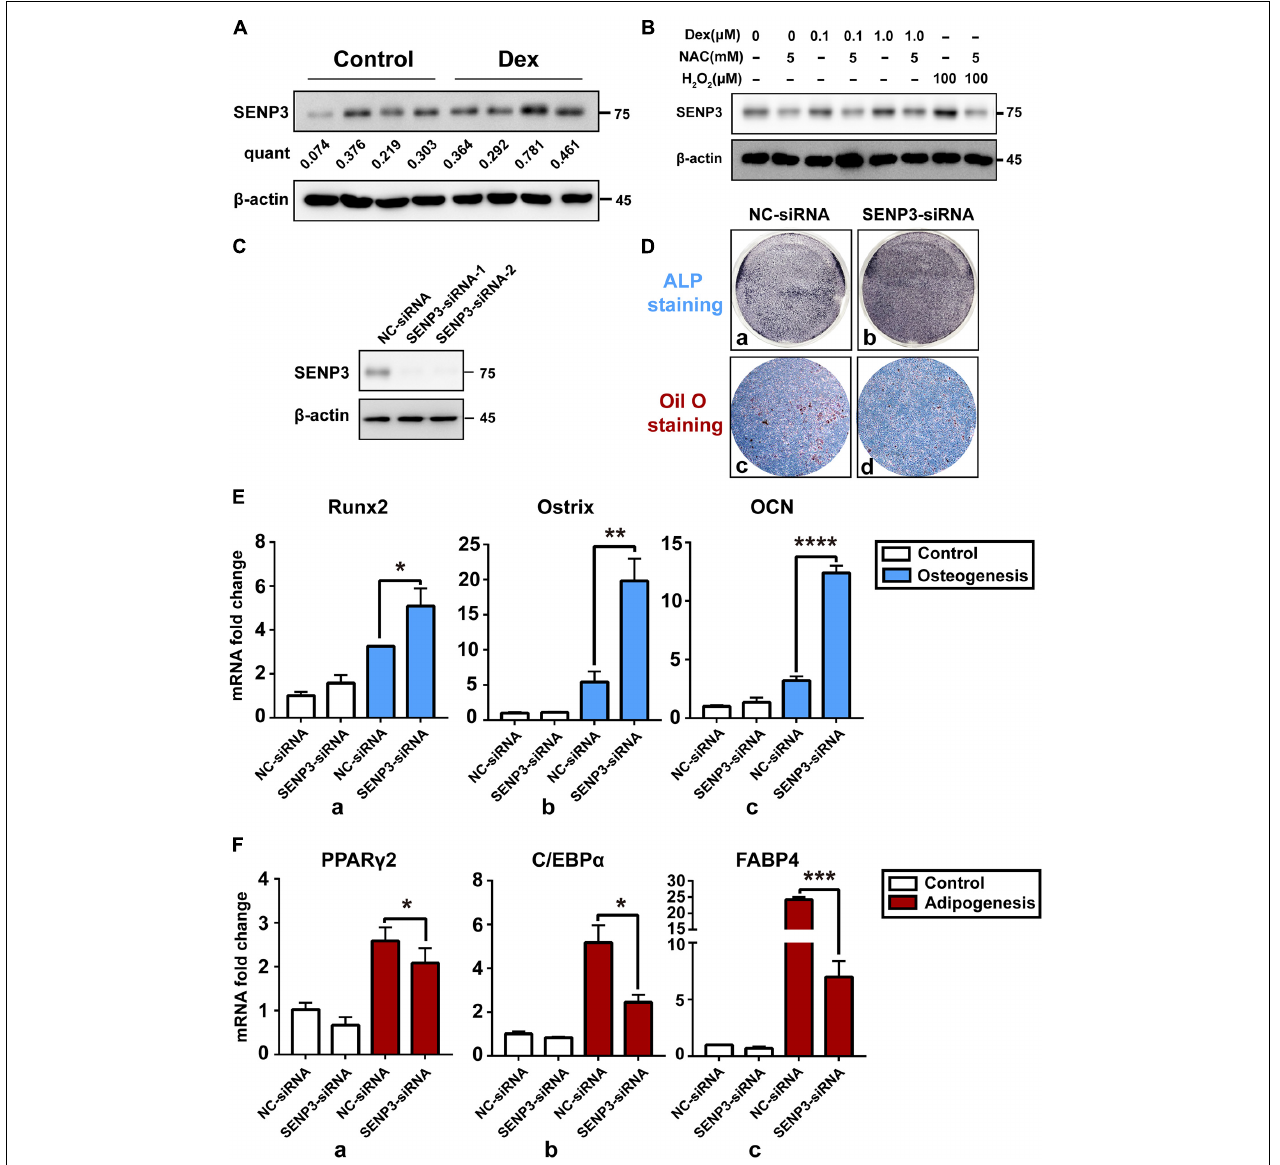
FIGURE 3 | Upregulated cellular SENP3 under oxidative stress in BM-MSCs can promote adipogenesis and inhibited osteogenesis. (A) The protein level of SENP3 in BM-MSCs of control and GIOP mice were shown by Western Blotting and the ratio of SENP3/ β -actin was listed below; (B) the protein level of SENP3 in BM-MSCs after 0, 0.1, 1.0 µ M Dex treatment for 24 h with/without 5 mM NAC treatment, 100 µ M H 2 O 2 treatment for 30 min was used as positive control; (C) the expression of SENP3 in BM-MSCs transfected by NC-siRNA and SENP3-siRNA for 36 h was shown by Western Blot; (D) The ALP staining and Oil Red O staining of BM-MSCs transfected by NC-siRNA (a,c) and SENP3-siRNA (b,d) after osteogenic induction for 7 days and adipogenic induction for 14 days; (E) the expression of osteogenic marker genes including Runx2 (a) , Ostrix (b) , OCN (c) in BM-MSCs with NC-siRNA and SENP3-siRNA transfected in day 0 and day 7 after osteogenic induction was detected by Q-PCR; (F) The expression of adipogenic marker genes including PPAR γ 2 (a) , C/EBP α (b) , fatty acid binding protein 4 (FABP4, c ) in BM-MSCs with NC-siRNA and SENP3-siRNA transfected in day 0 and day 7 after adipogenic induction was detected by Q-PCR. Data are shown as the mean ± SEM. * p < 0.05, ** p < 0.01, *** p < 0.005, **** p < 0.001. All the data were obtained from at least three independent